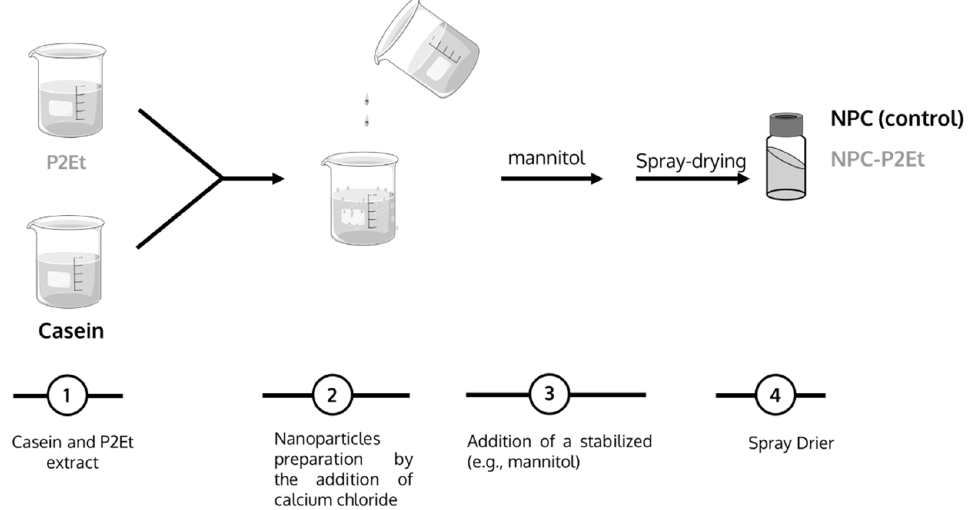
Figure 1. Schematic representation of the preparative process of NPC (control; empty casein nanoparticles) and NPC-P2Et (P2Et-loaded casein nanoparticles).